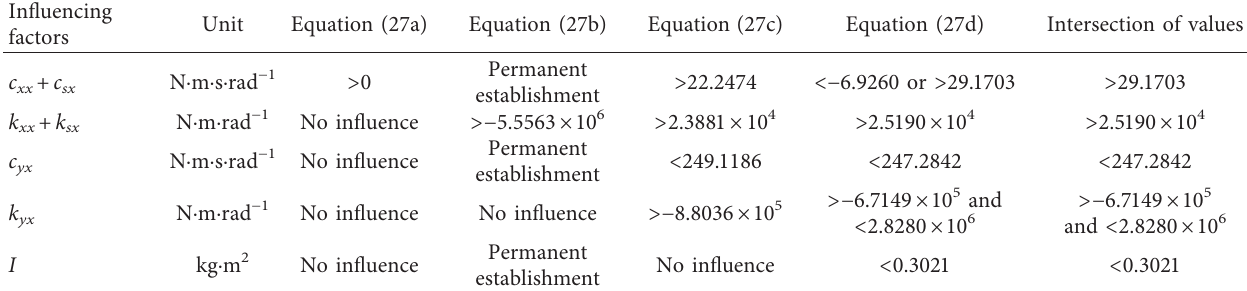
Table 1: Characteristic parameter values of DGS system under critical instability state according to Hurwitz stability criterion. Influencing